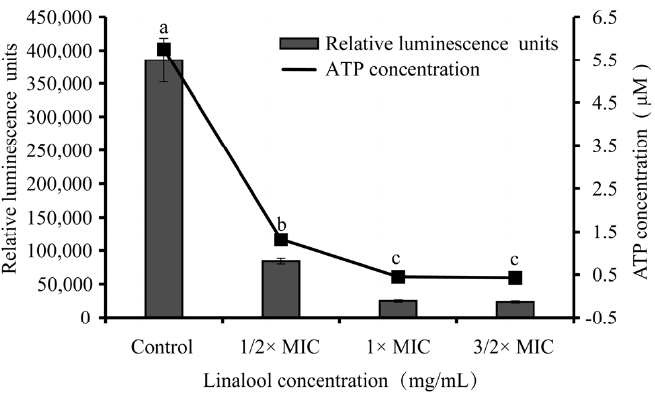
Figure 4. The effects of linalool on intracellular ATP production by S. sonnei . Values represent the means of independent triplicate measurements. Bars represent the standard deviation ( n = 3). Different letters indicate a significant difference cross the figure ( p < 0.01).